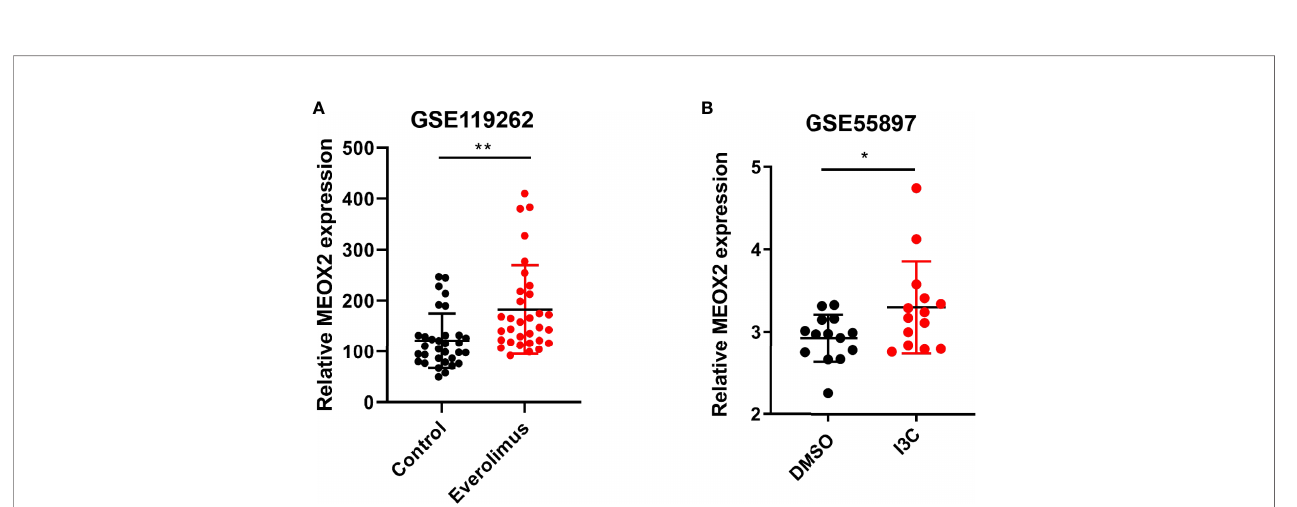
FIGURE 3 | Expression level of MEOX2 is increased in breast cancer with drug treatment in GEO dataset. (A) Treatment of breast cancer patients with the mTOR inhibitor everolimus in the GSE119262 dataset. (B) Breast cancer cells treated with I3C in the GSE55897 dataset. *p < 0.05, **p < 0.01.